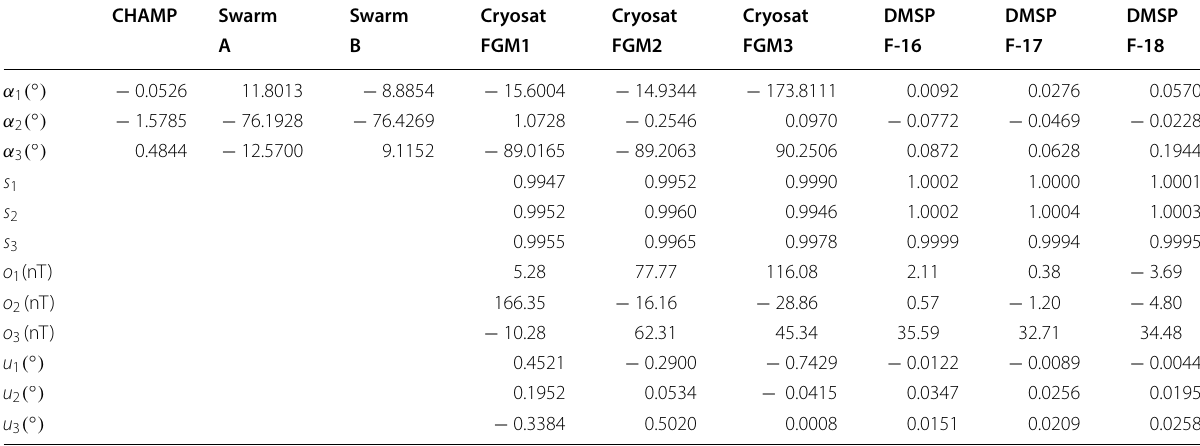
Table 4 Model A mean alignment and calibration